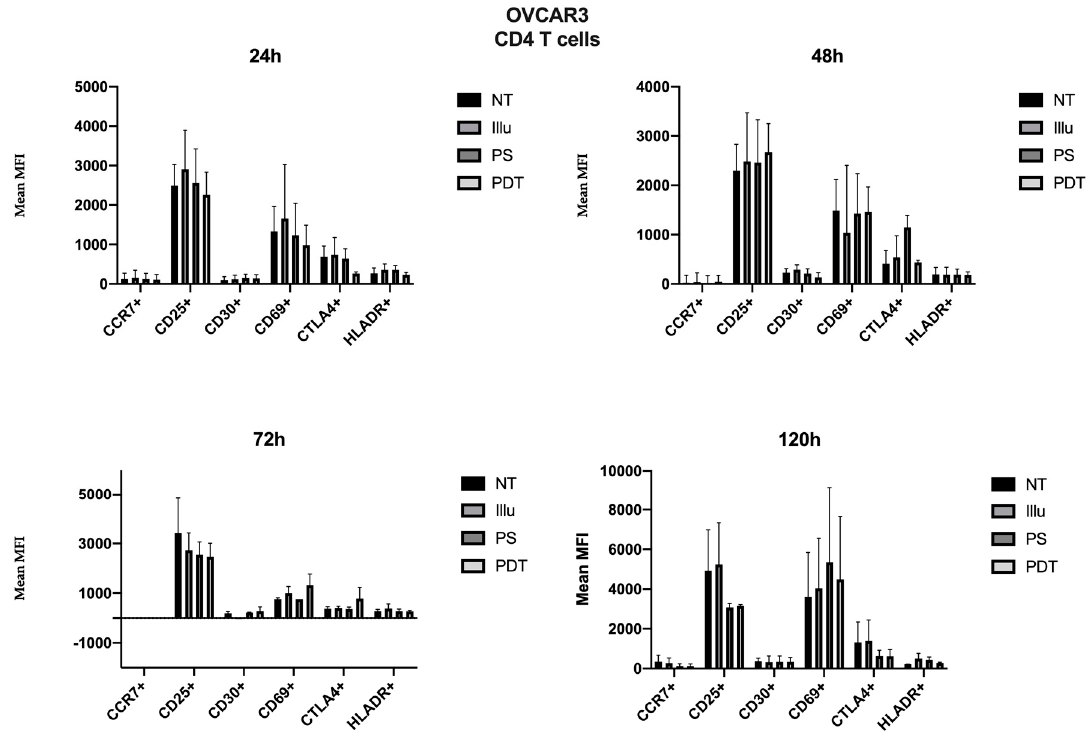
Figure 7. FACS analysis of activating markers of CD4 + T cells cultured with conditioned media of OVCAR3 cells at 24 h, 48 h, 72 h and 120 h. NT: non-treated, PS: Photosensitizer only, illu: illumination only, PDT: illumination in the presence of PS, ML10: the raw culture media of PBMC. Results are expressed in Mean of MFI ( n = 3 independent donors).